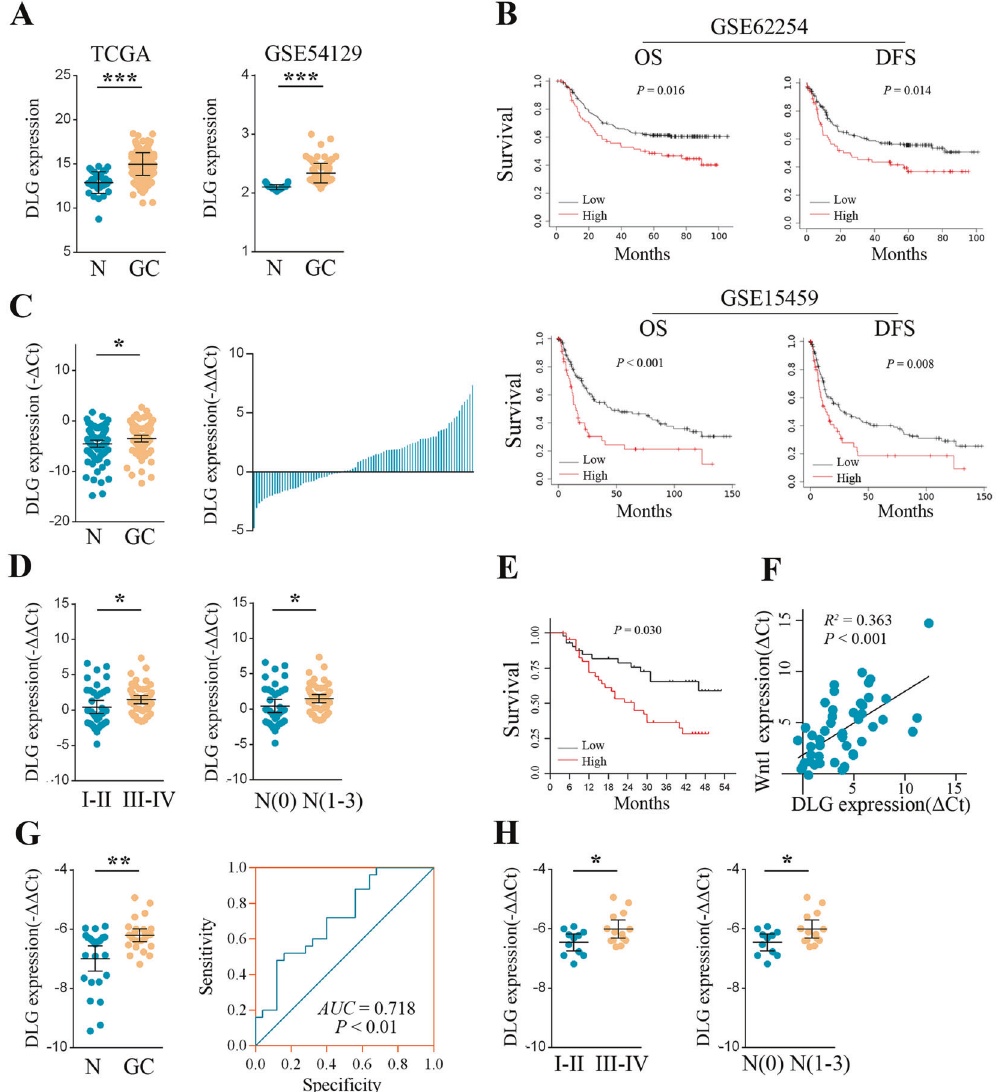
Fig. 1 DLGAP1-AS2 was upregulated in GC. A Relative expression of DLGAP1-AS2 in GC compared with normal tissue was analyzed by using the TCGA database and GSE54129 dataset. B Kaplan – Meier analysis of OS and DFS in GSE662254 and GSE15459 datasets. C RT ‐ qPCR assay for the expression of DLGAP1-AS2 in 85 paired GC tissues and adjacent non-cancerous tissues. D The correlation between tissue DLGAP1-AS2 level and TNM stage as well as lymphatic metastasis. E Kaplan – Meier analysis of OS according to the median expression level of DLGAP1-AS2 in GC patients. F The correlation between DLGAP1-AS2 and Wnt1 expression was determined by Pearson correlation analysis. G The expression of DLGAP1-AS2 in plasma from 25 GC patients and paired healthy donors. The accuracy for plasma DLGAP1-AS2 in the diagnosis of GC was analyzed by the ROC curve. H The correlation between plasma DLGAP1-AS2 and TNM stage or lymphatic metastasis. DLG: DLGAP1- AS2. * P < 0.05, ** P < 0.01, *** P <